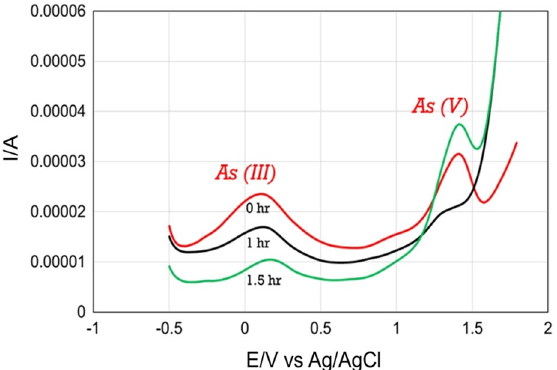
Figure 6. DPV measurements after treatment with A . xylosoxidans BHW-15. DPVs were obtained after treatment of arsenic solution with A . xylosoxidans BHW-15 for 0 h, 1 h, and 1.5 h respectively. Electrochemical measurement was done with a modified GCE/P-Arg/ErGO-AuNPs sensor in pH 6.0 phosphate buffer at a scan rate of 50 mV s −1 . The condition of DPV measurements was initial potential − 1.0 V, end potential 2.0 V, pulse width 50 ms, modulation 50 mV, and pulse period 0.1 s.